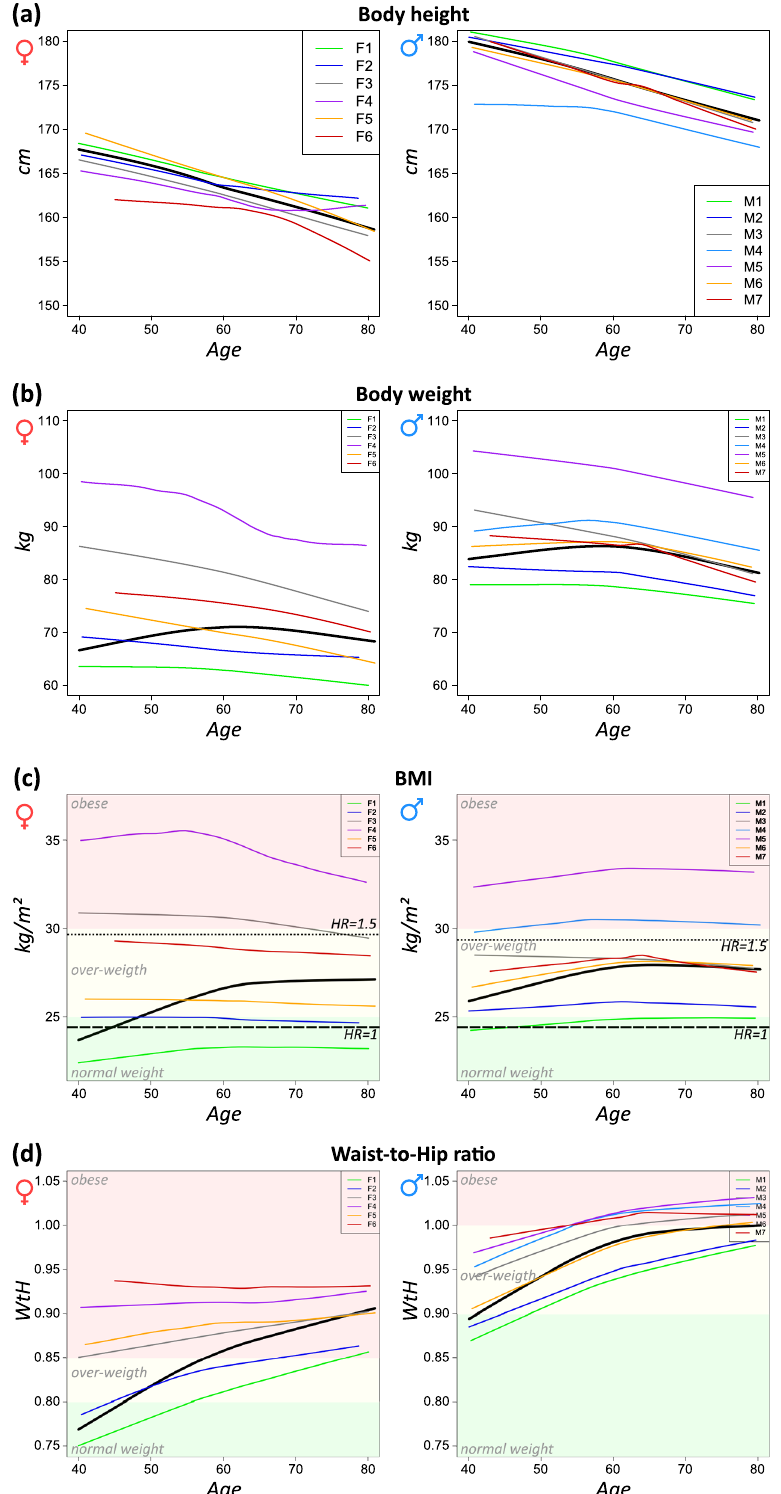
Fig. 6 Body height, weight, BMI, and WTH of body types as a function of age. Curves were smoothed for each body type. Thick black lines indicate the mean parameter development averaged over all female (left panels) and male participants (right panels), respectively. Gender- unspeci fi c body types B1 and B2 are not shown here due to low sample sizes. The background colors in c , d indicate different weight categories as indicated. The horizontal dashed line refers to minimum BMI-associated all-cause mortality (BMI = 24 kg/m 2 ) and the dotted lines to hazard ratios of 1.5 taken from ref. 25